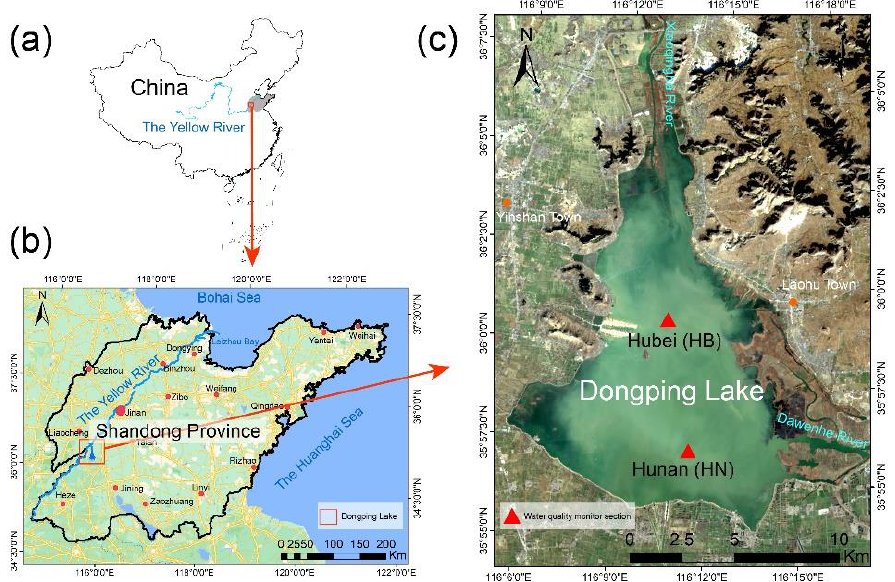
Figure 2. Geographic locations of the study area in China ( a ) and in Shandong Province ( b ), and the spatial distribution of the corresponding national water quality monitoring sections against a Landsat 8 false-color composite image ( c ).